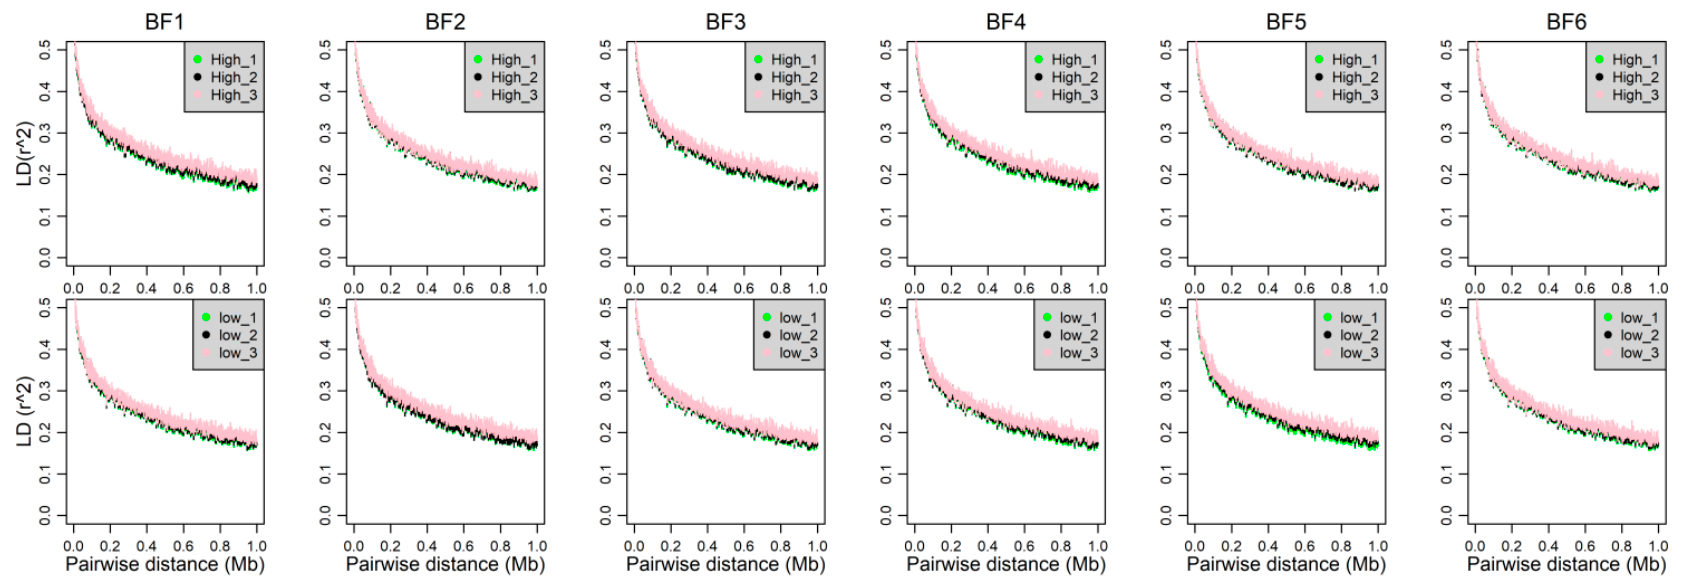
Figure 3. The decay of linkage disequilibrium of all subpopulations across the genome. The pairwise linkage disequilibrium ( r 2 ) is plotted against the corresponding physical distances. High_1 (High_2, High_3) and Low_1 (Low_2, Low_3) represent the two subpopulations of 1st (2nd and 3rd) population pair. LD: linkage disequilibrium.